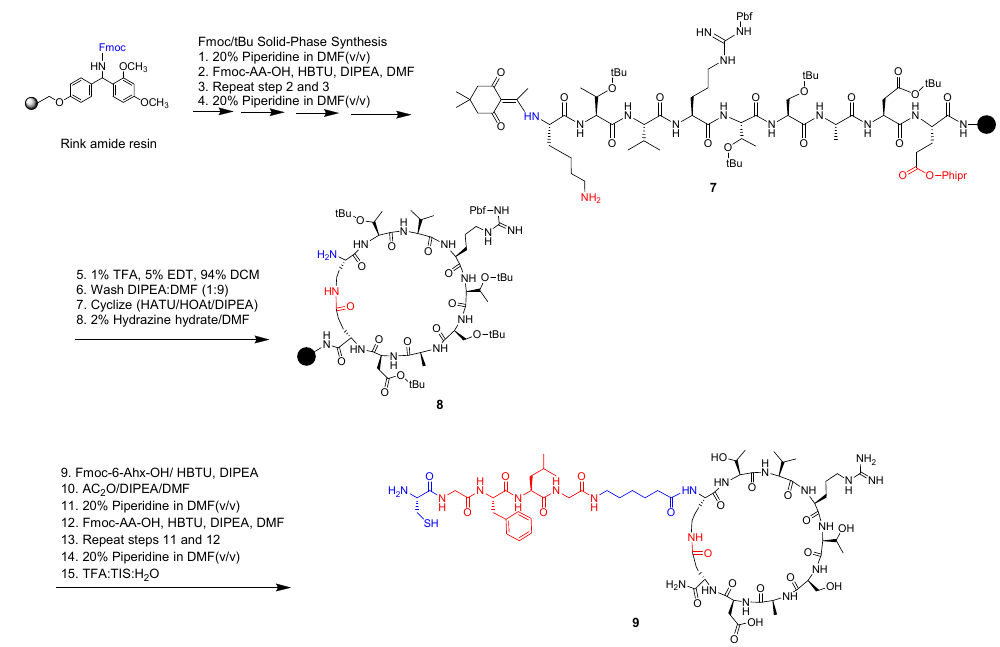
Scheme 2. Selected synthesis of C-GFLG-C 6 -[KTVRTSADE] 9 containing lactam